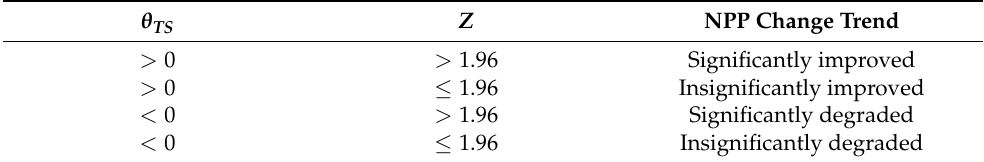
Table 3. Rules for the trend classification of NPP